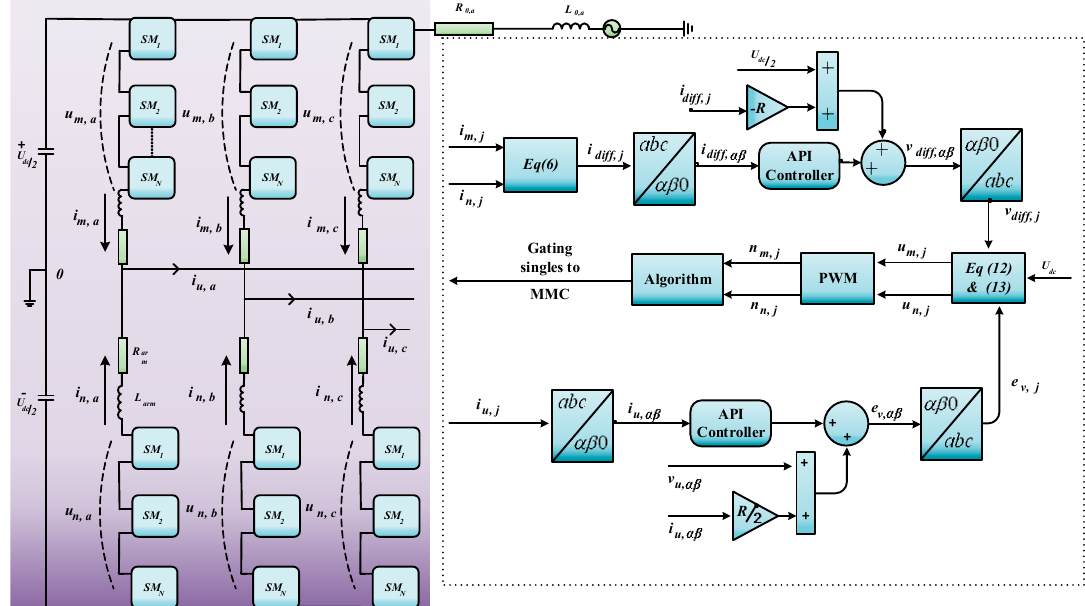
Figure 10. Overall control design for output and circulating currents.